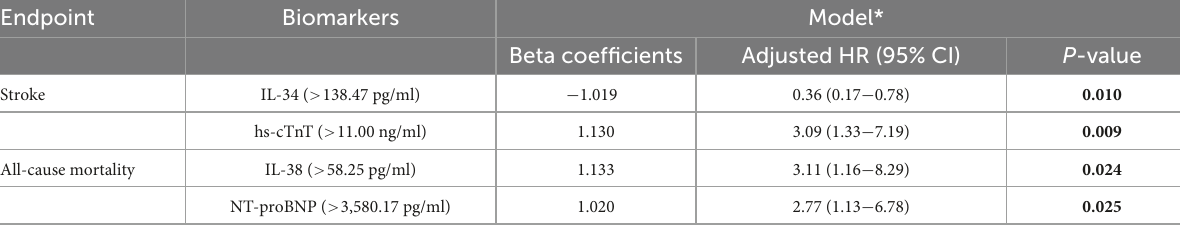
TABLE 2 Associations between biomarkers concentrations and events during follow-up in atrial fibrillation (AF) patients.